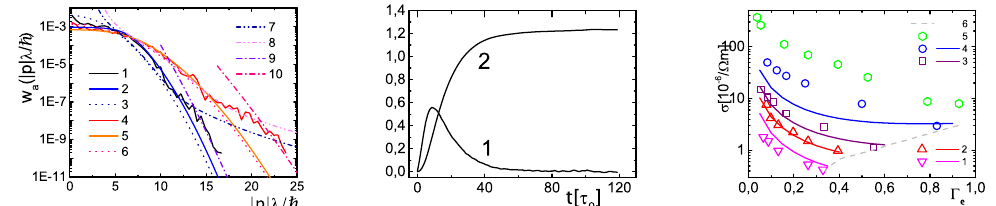
Figure 1. (Color online) ( Left ) The momentum distribution functions w a ( | p | ) for interacting electrons and two times heavier holes. The electronic momentum distributions are presented by Lines 1, 2, 3, 7, and 9, while analogous results for holes are presented by Lines 4, 5, 6, 8, and 10. The physical meaning of these lines is given in text. Degeneracy of electrons is equal to 4 ( T / E F = 0.261, k F λ e = 4.91), while r s and the plasma classical coupling parameter is equal to 2. ( Central ) The velocity–velocity autocorrelation function (Line 1) and its antiderivative function (Line 2) versus time in atomic units ( τ 0 = ¯ h /Ha) for r s = 6, T = 1.27Ha. ( Right ) Electrical electron conductivity as function of the coupling parameter Γ e for different fixed densities of two component Coulomb system. Empty scatters 1–5 show results of this work for the fixed r s = 6,4,3,2,1, respectively, while related lines present results of interpolation formula for conductivity of fully ionized hydrogen plasma [26,27]. Line 6 restricts approximately from above the region of conductivity sharp drop due to arising bound states of many particle